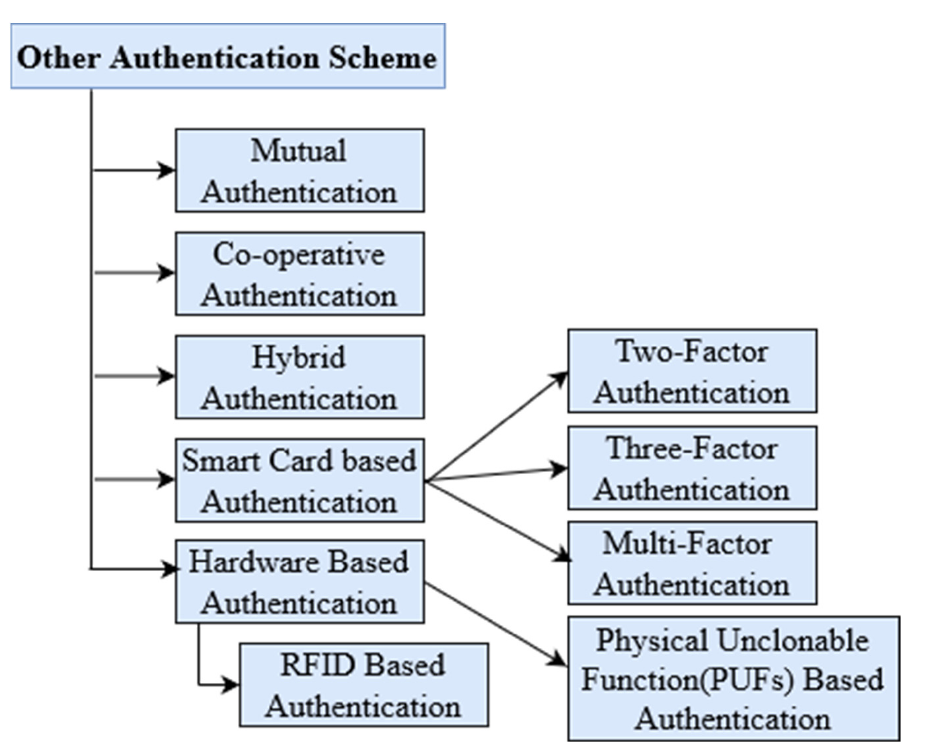
Figure 6. Other Types of Authentication Schemes.